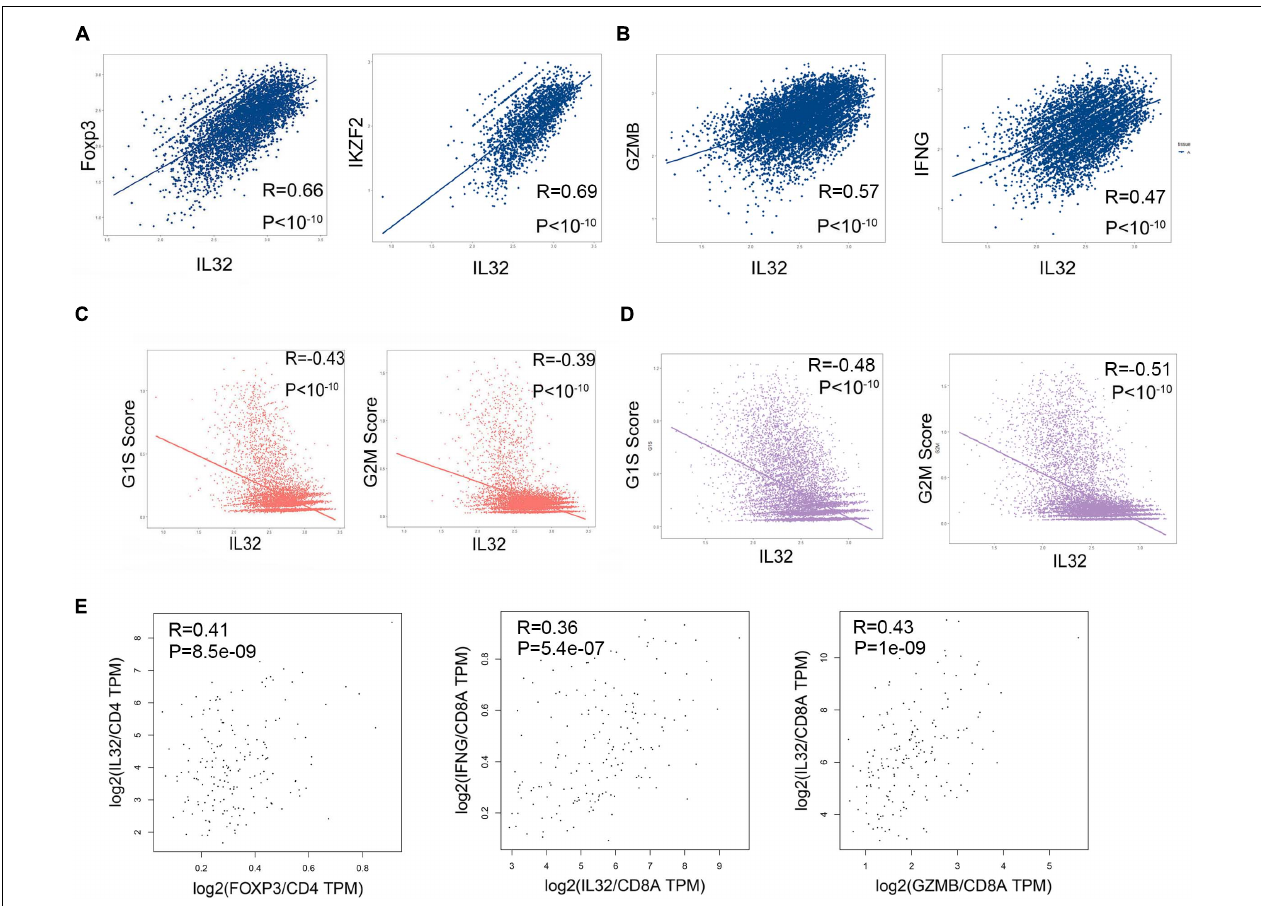
FIGURE 3 | Correlation between IL-32, cell cycle scores, and multiple gene expressions. (A) Pearson correlation coefficient demonstrates the correlation between IL-32 and Foxp3, IFZF2 in CD4 + T cells from ESCC tumor tissues. (B) Pearson correlation coefficient demonstrates the correlation between IL-32 and GZMB and IFNG in CD8 + T cells from ESCC tumor tissues. (C) Pearson correlation coefficient demonstrates the correlations between IL-32 and G1S scores and G2M scores in CD4 + T cells from ESCC tumor tissues. (D) Pearson correlation coefficient demonstrates the correlations between IL-32 and G1S scores and G2M scores in CD8 + T cells from ESCC tumor tissues. (E) The correlations between IL-32 and Foxp3 expression (left panel), gene expression was normalized in CD4; the correlation between IL32 and IFNG expression (middle panel) and GZMB expression (right panel), gene expression was normalized in CD8a, from ESCA bulk RNA sequence data. The R value represents the correlation between the x and y axis values, R > 0 means a positive correlation, R < 0 means a negative correlation, and p < 0.01 indicates that the correlation was statistically